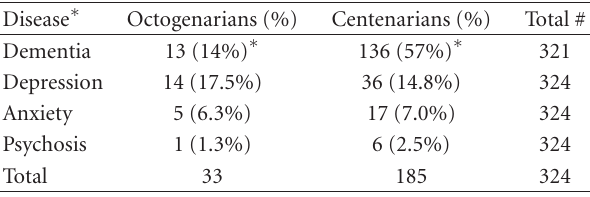
Table 2: The lifetime prevalences of psychiatric disorders other than dementia in centenarians versus octogenarian control group in GCS [3] do not di ff er.